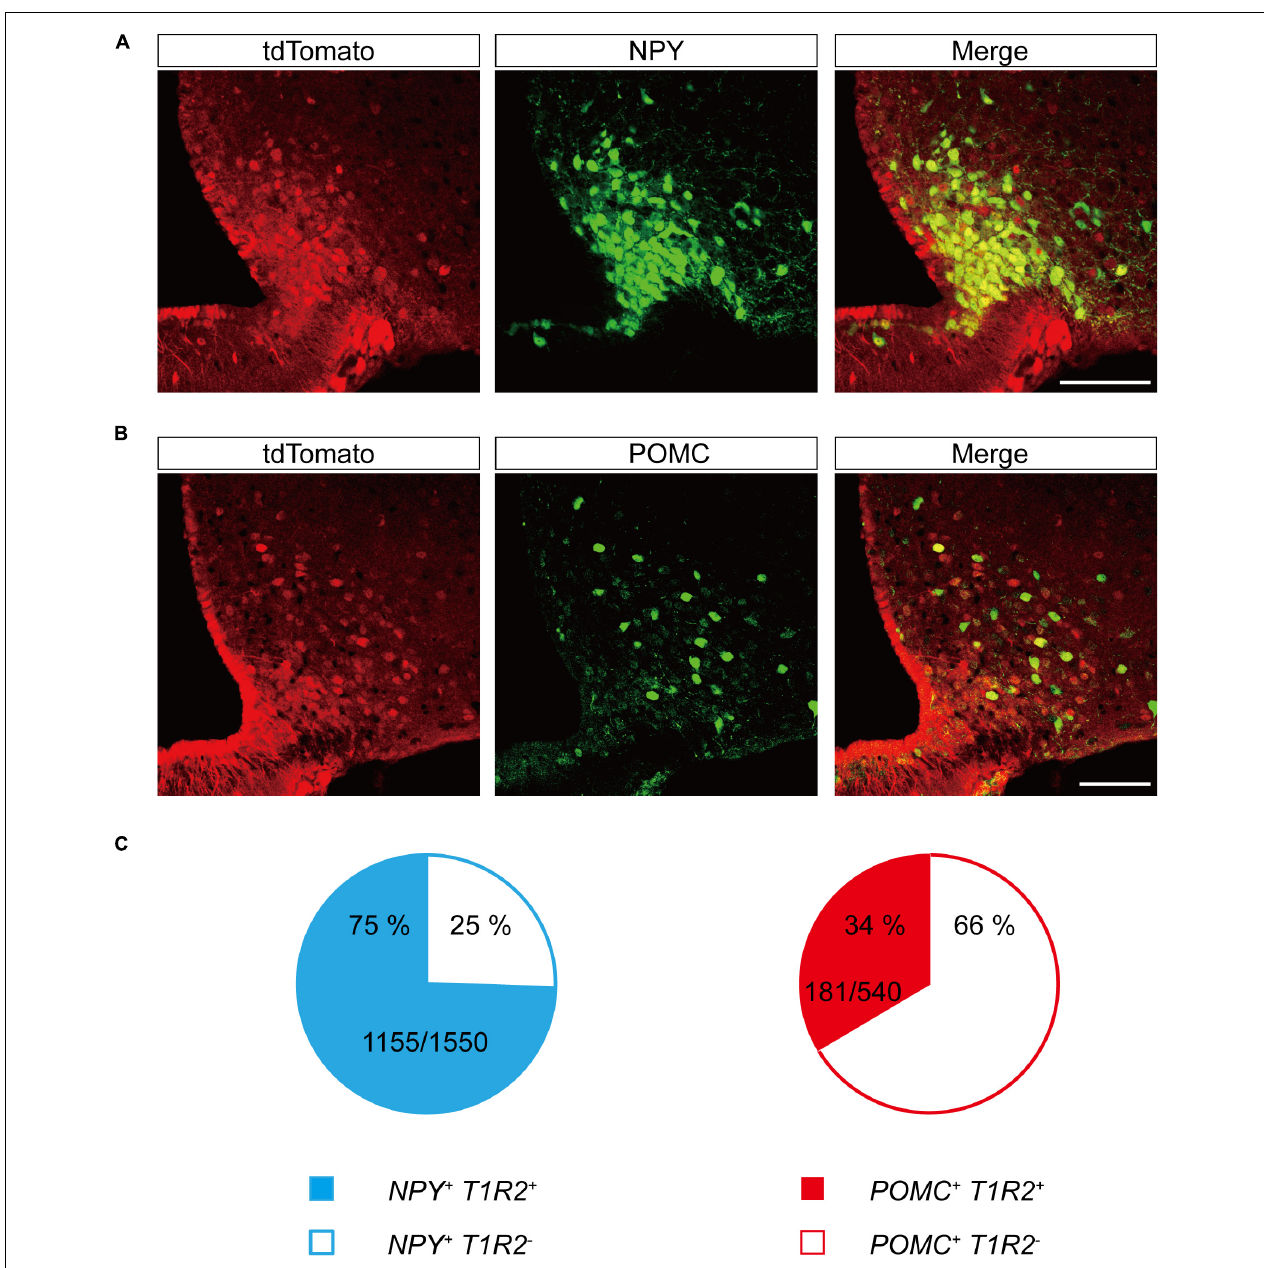
FIGURE 8 | Representative confocal images showing tdTomato fluorescence in hypothalamic neuropeptide Y (NPY) or proopiomelanocortin (POMC)-expressing neurons of T1r2 -tdTomato mice. (A) Co-expression of tdTomato with Npy-hrGFP . (B) Co-expression of tdTomato with POMC-hrGFP . Anti-GFP signals (green), and tdTomato (red). Scale bar, 100 µ m. (C) Quantification of hypothalamic NPY neurons (blue) and POMC neurons (red) that co-express tdTomato. Filled and blank areas indicate the presence and absence of tdTomato expression,